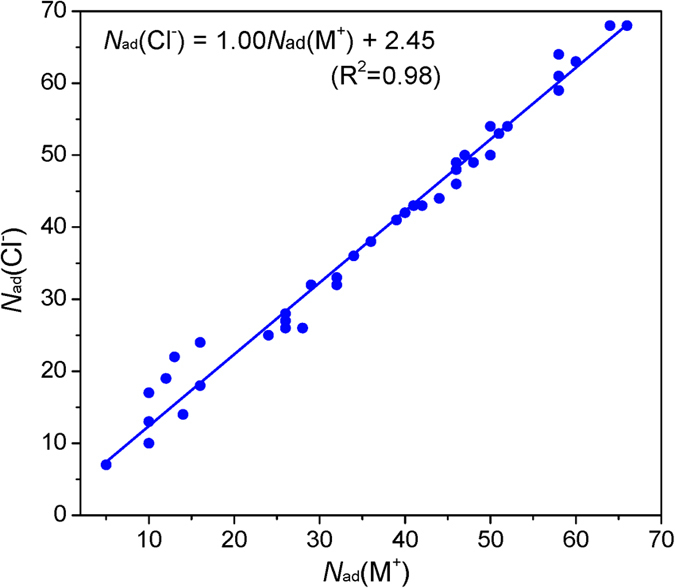
Correlation of the adsorbed quantities between metal cations (M+) and anions (Cl−).Both inner- and outer-sphere adsorbed ions are counted. Pb2+ is two molar equivalents of M+; i.e., Nad(Pb2+) = 2*Nad(M+).